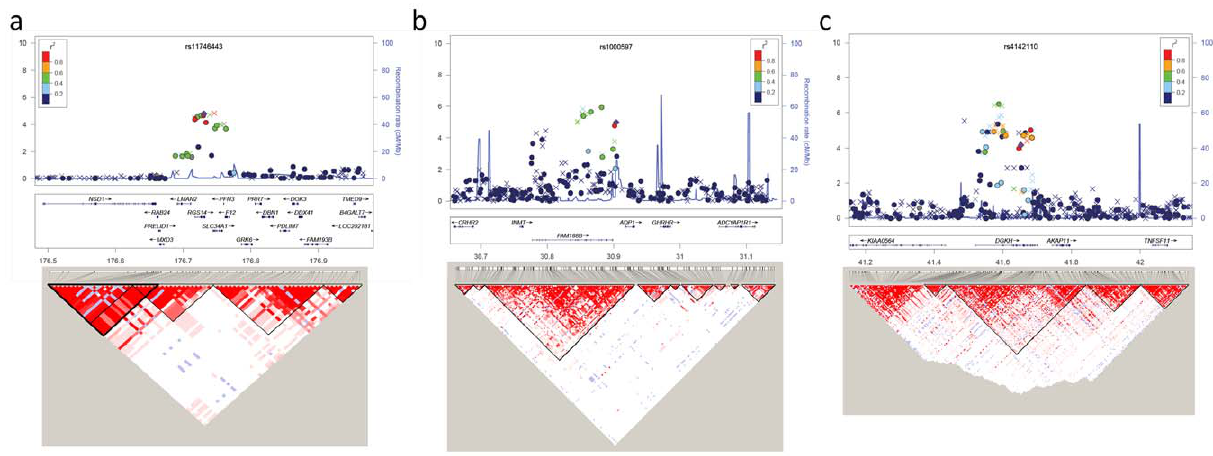
Figure 1. Regional association plots at rs11746443, rs1000597, and rs4142110 loci. (a–c) Upper panel; P -values of genotyped SNPs (circle) and imputed SNPs (cross) are plotted (as 2 log 10 P -value) against their physical position on chromosome 5 (a), 7 (b), and 13(c) (NCBI Build 36). SNPs rs11746443 on 5q35 (a), rs1000597 on 7p14 (b), and rs4142110 on 13q14 (c) are represented by purple diamonds. The genetic recombination rates estimated from 1000 Genomes samples (JPT + CHB) are shown with a blue line. SNP’s color indicates LD with rs11746443 (a), rs1000597 (b), and rs4142110 (c) according to a scale from r 2 =0 to r 2 =1 based on pair-wise r 2 values from HapMap JPT. Middle Panel; Gene annotations from the University of California Santa Cruz genome browser. Lower Panel; We drew the LD map based on D ’ values using the genotype data of the cases and controls in the GWAS samples.